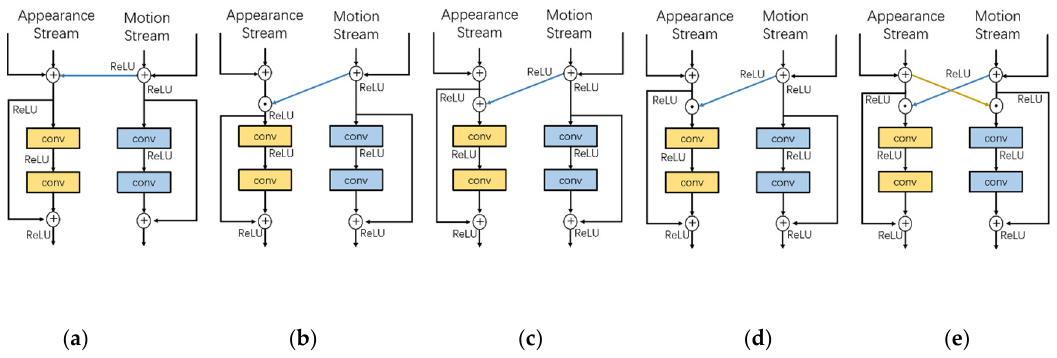
Figure 5. Several types of cross-stream connections for capturing spatial and temporal features simultaneously. ( a – d ) The connections of direction from motion to the appearance stream; ( e ) the bidirectional connections.